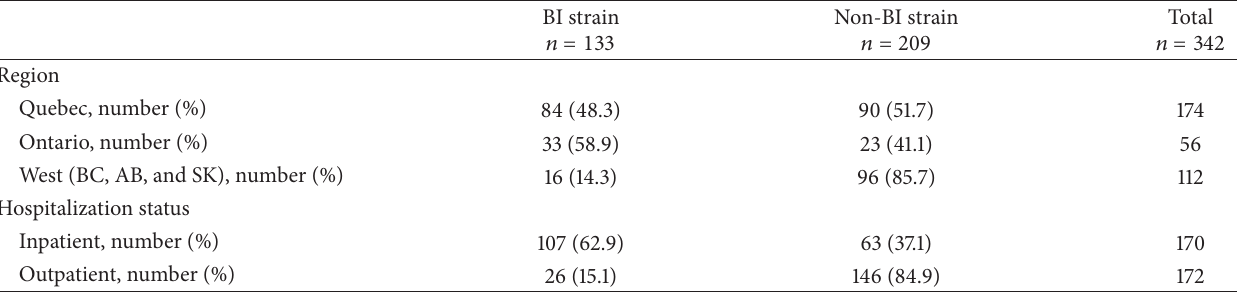
BI strain 𝑛 = 133